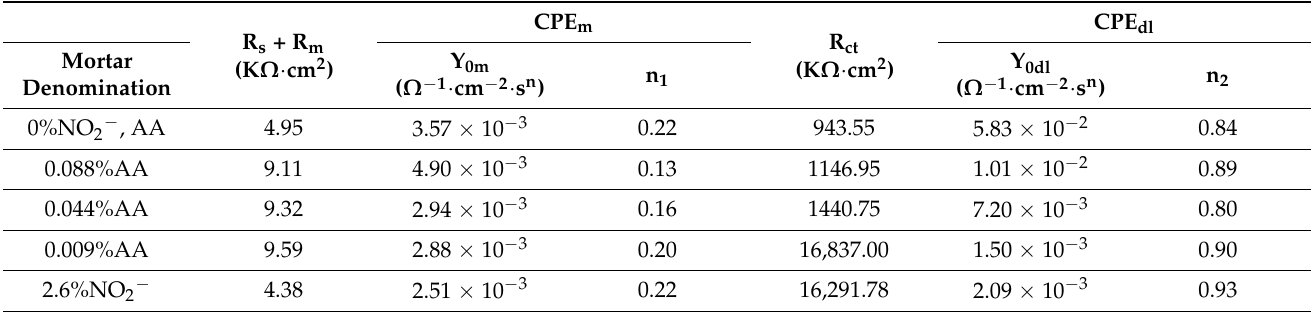
Table 4. Fitting impedance data using the EEC on Figure 5 for steel bars embedded in chloride- contaminated mortars, with 0.088, 0.044 and 0.009% of AA and 2.6% of NO 2 −